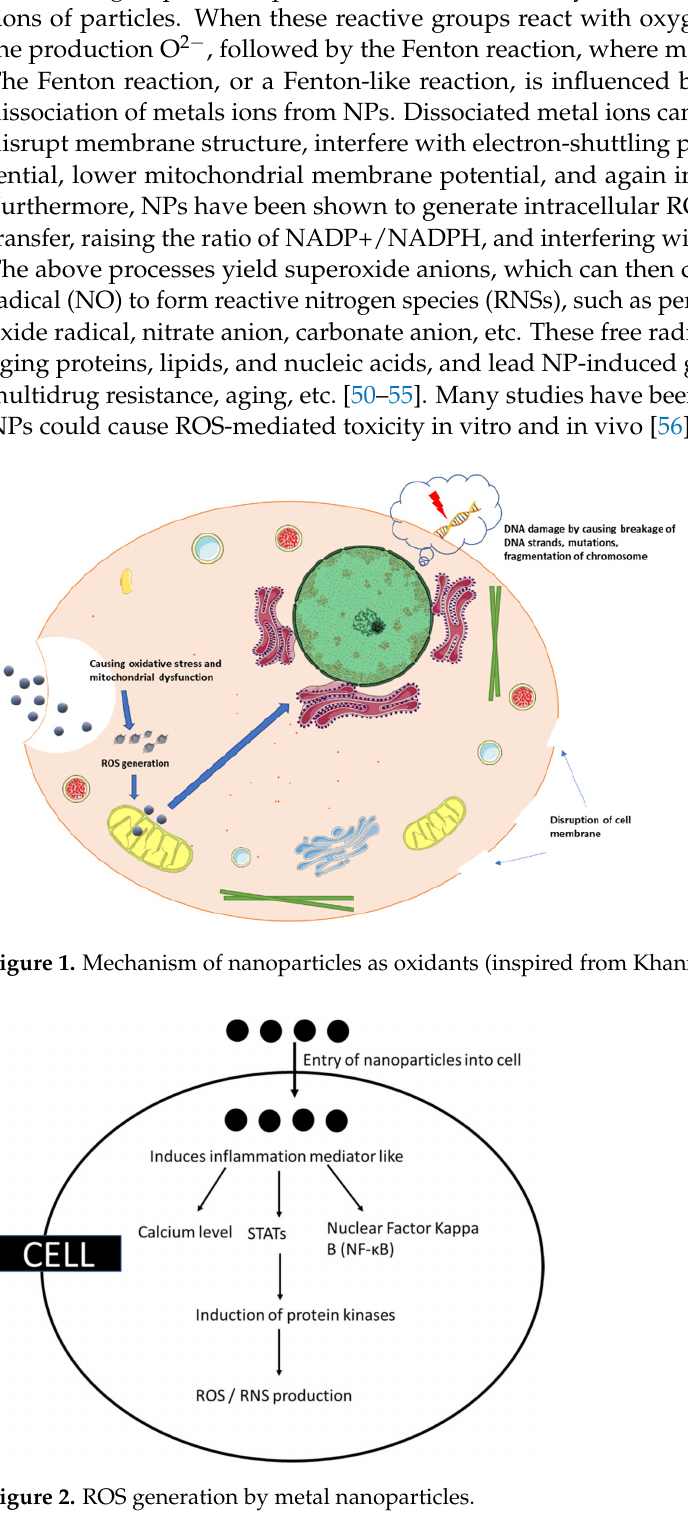
Figure 2. ROS generation by metal